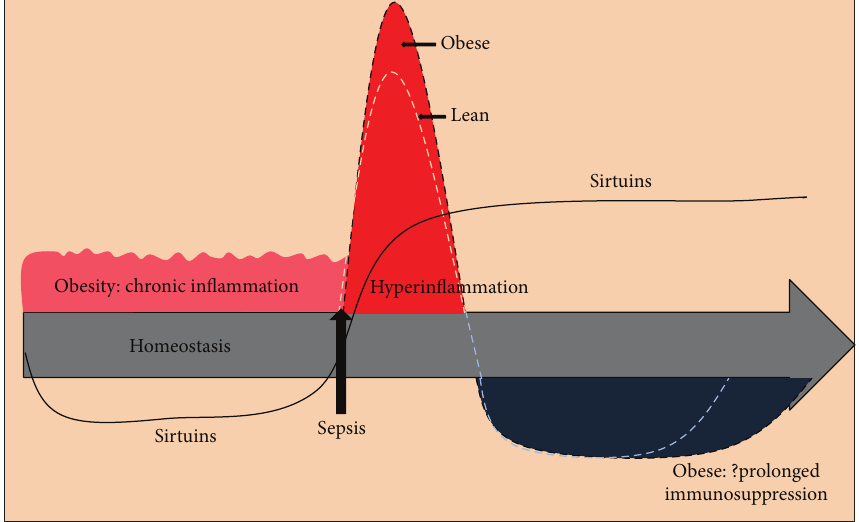
Figure 3: Sirtuins and obesity with sepsis: obesity is associated with low-sirtuin levels/activity, but mechanisms responsible for this imbalance are unknown. If sepsis occurs in obese individuals with low SIRT1, the early hyperinflammatory phase is accentuated and counteractive adaptation stage may be prolonged. Activating SIRT1 before obesity-associated sepsis prevents the accentuated acute inflammatory